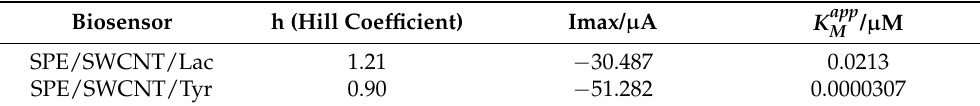
Table 4. Characteristic parameters of SPE/SWCNT/Tyr and SPE/SWCNT/Lac for OLEU.